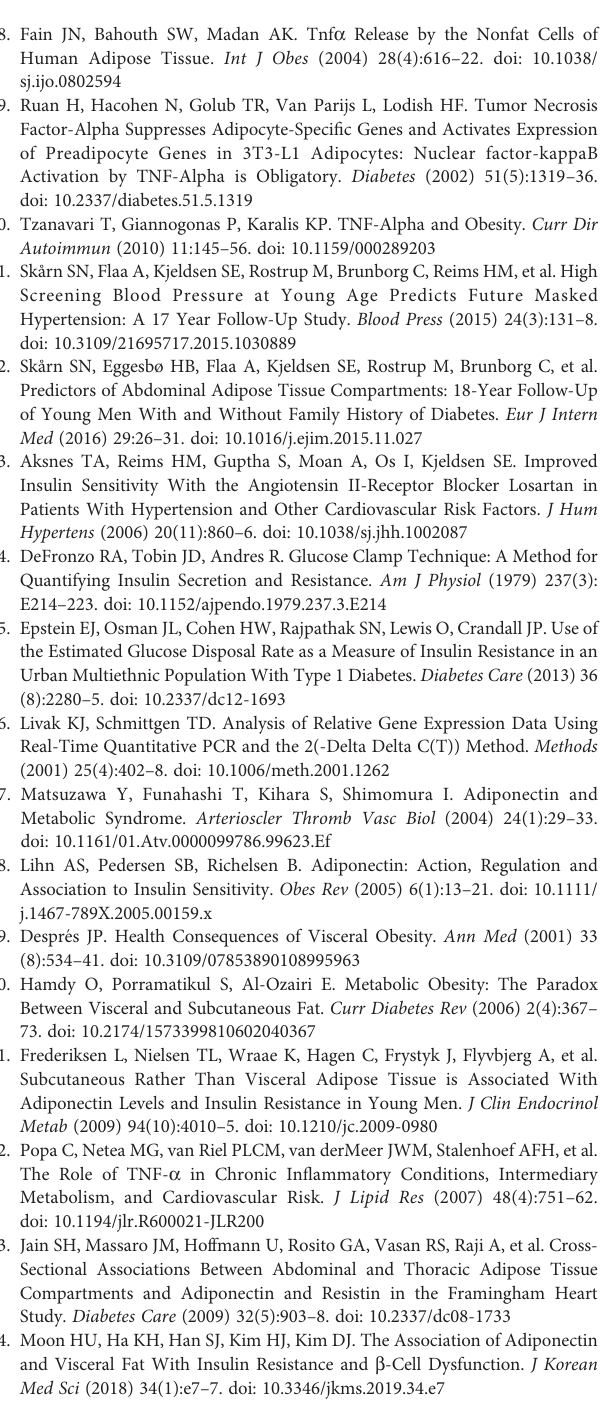
the measured markers in the overweight population (BMI >25) (n = 62). AT, adipose tissue; sSAT, super fi cial subcutaneous adipose tissue; dSAT, deep subcutaneous adipose tissue; VAT, visceral adipose tissue. *p < 0.05 Supplementary Table 3 | Correlation (Spearmans Rho) between genetically expressed adipokines and corresponding circulating levels. AT; adipose tissue. s; serum levels. *p <